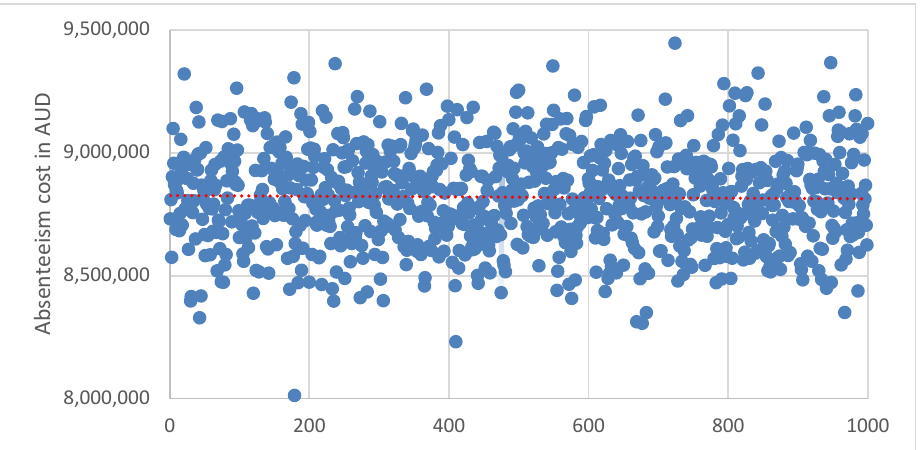
Figure 2. Scatter plot for probabilistic sensitivity analysis to examine the uncertainty of parameters in estimating absenteeism cost using Monte Carlo simulation to replicate the estimated cost in 1000 samples. Average absenteeism cost was AUD 8.82 (95% CI: 8.81 – 8.83) million.